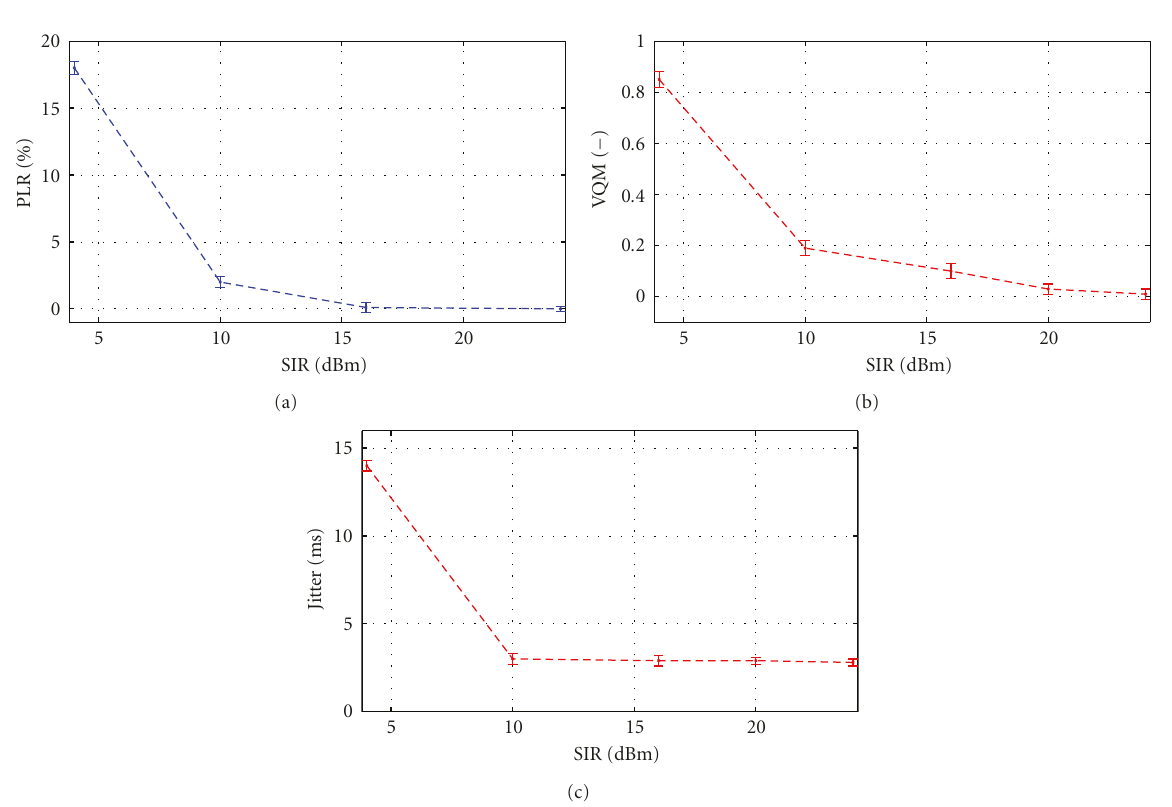
(v) VQM is lower than 0.1 (i.e., good video quality)